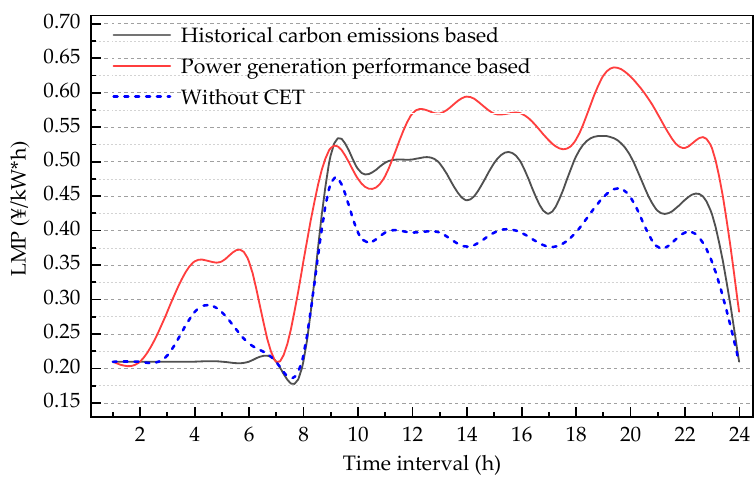
Figure 16. Comparison of locational marginal price (LMP) with different carbon emission quota allocation methods.